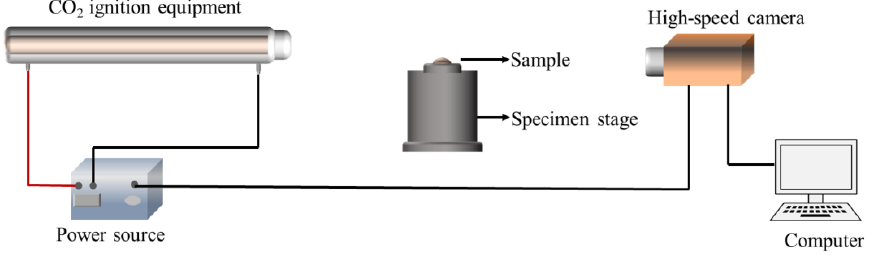
Figure 2. Schematic diagram of laser ignition platform.